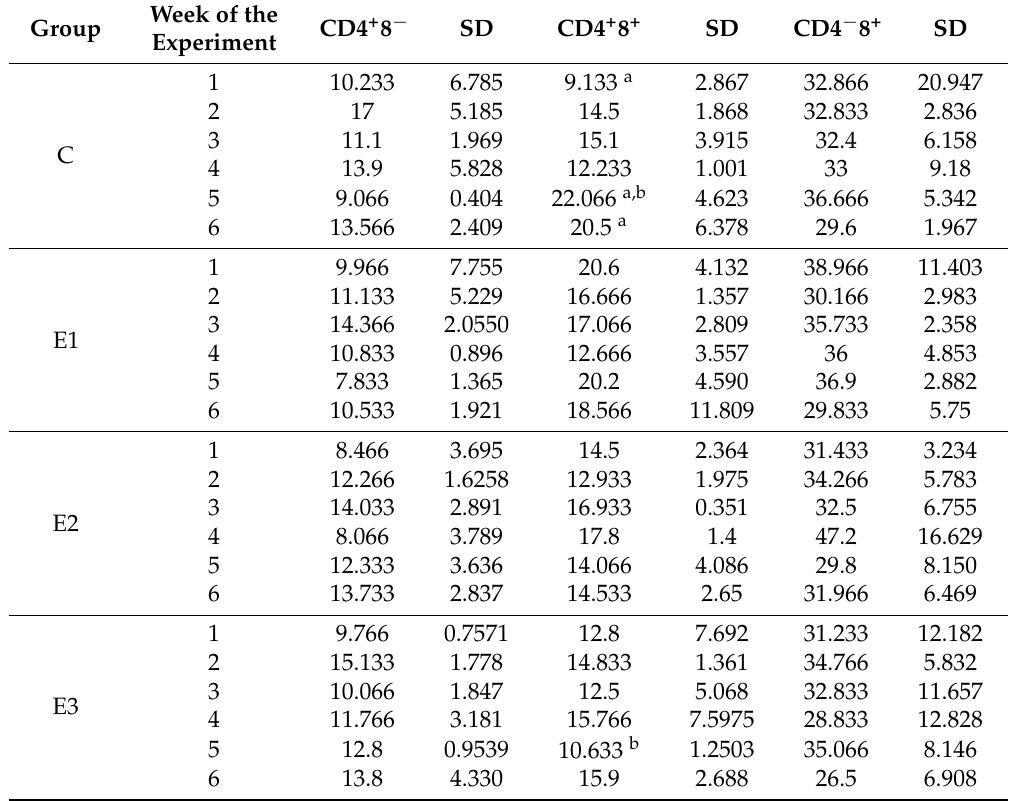
Table 1. Average percentages of lymphocyte subpopulations + SD.